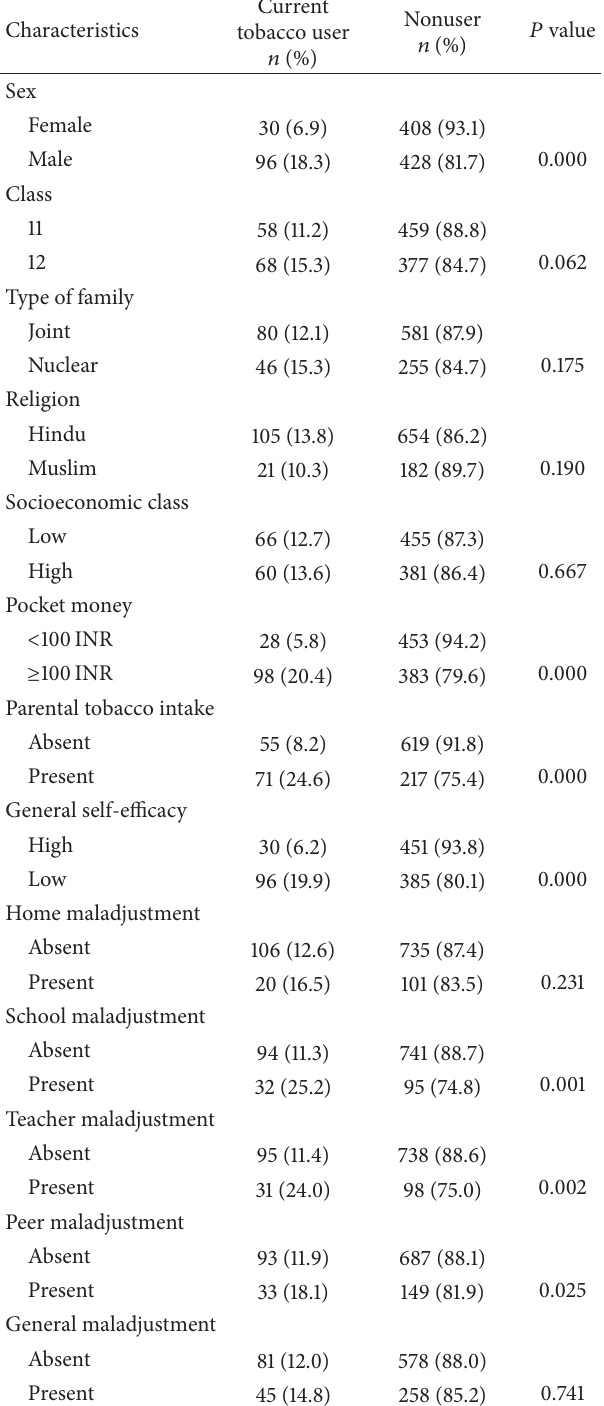
Table 2: Distribution of study participants according to current tobacco use ( 𝑁 = 962